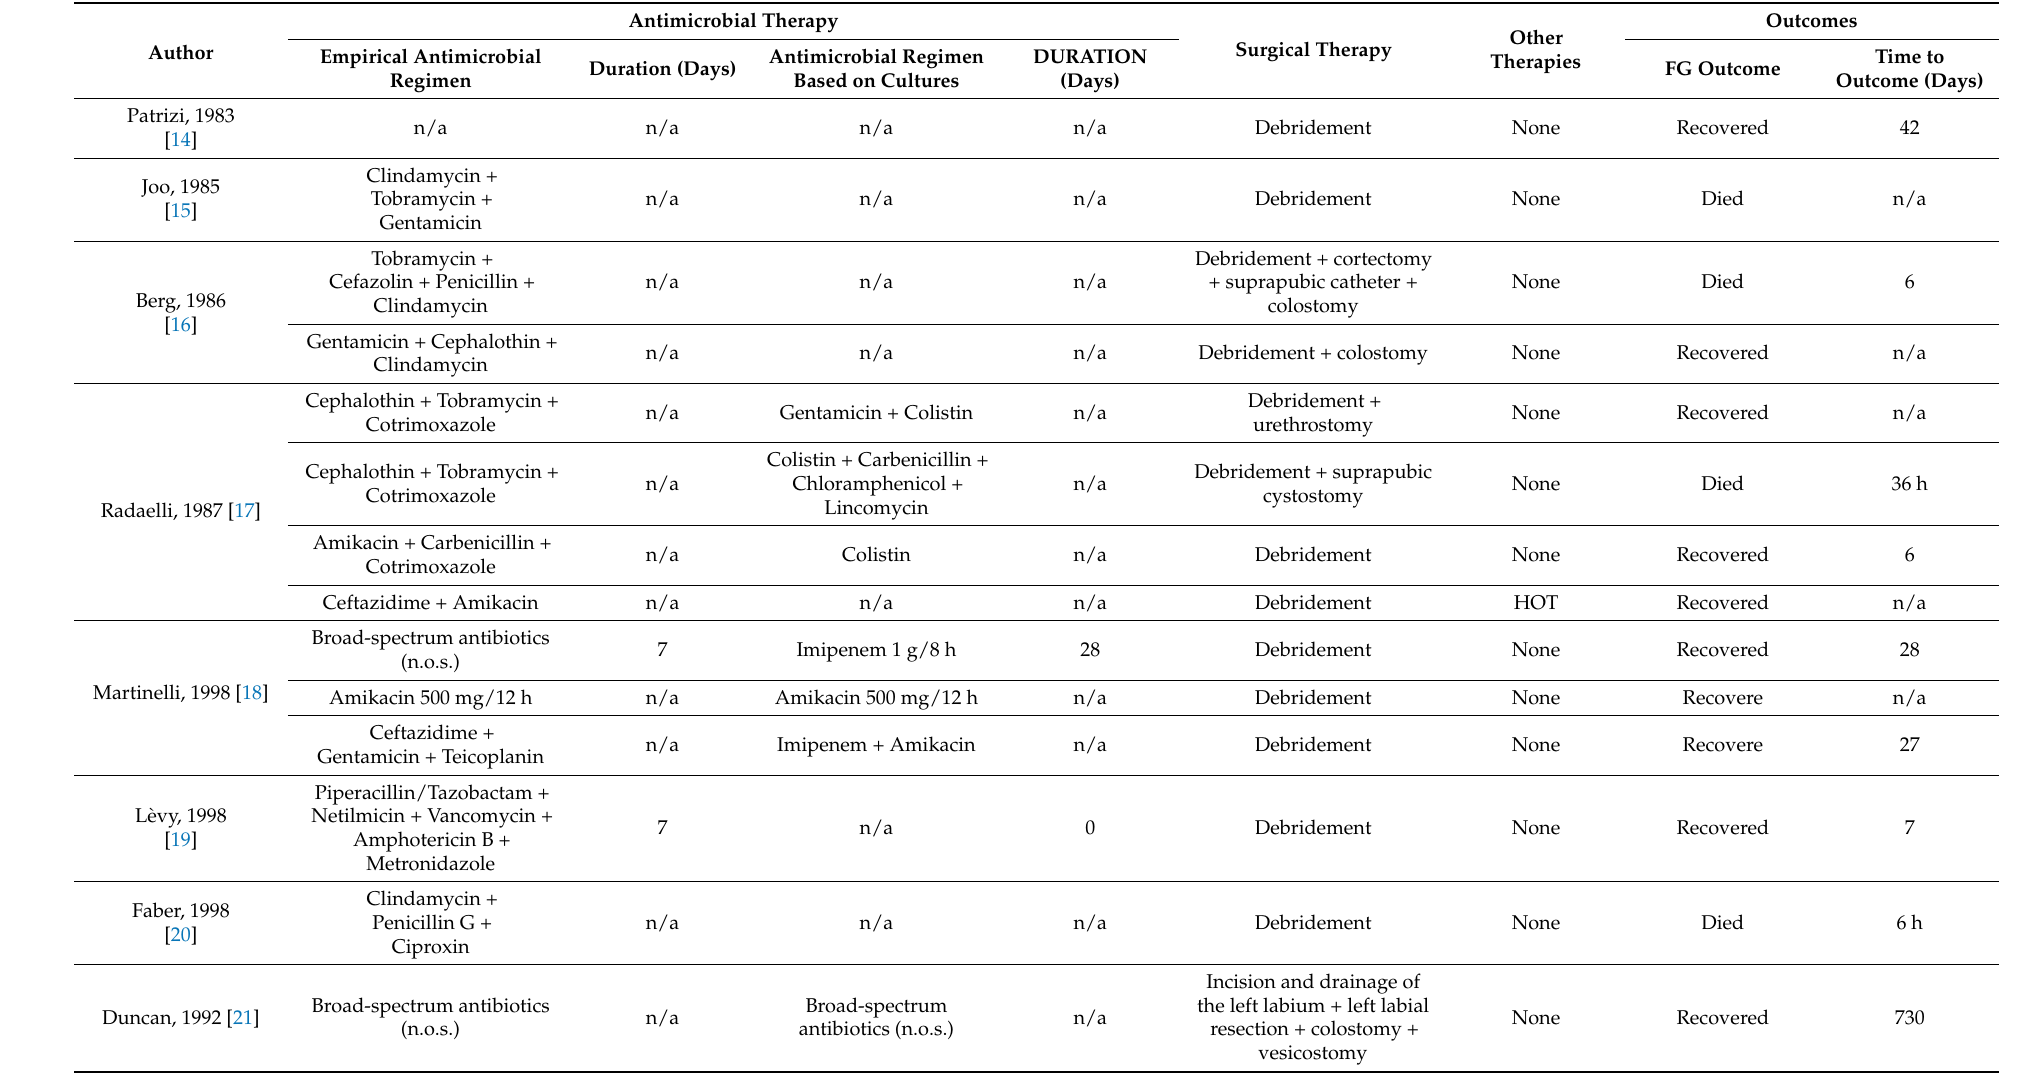
Table 2. Medical and surgical treatments and FG